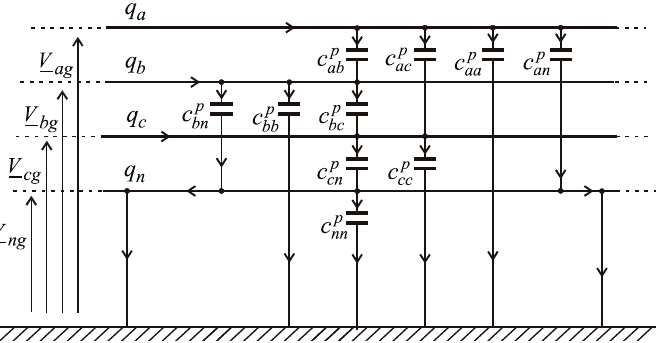
Figure 5. Unit length segment of a three-phase OHL and the primitive self and mutual capacities that are formed.